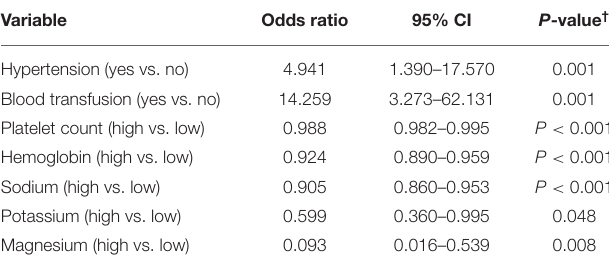
TABLE 2 | Multivariate competing risk regression